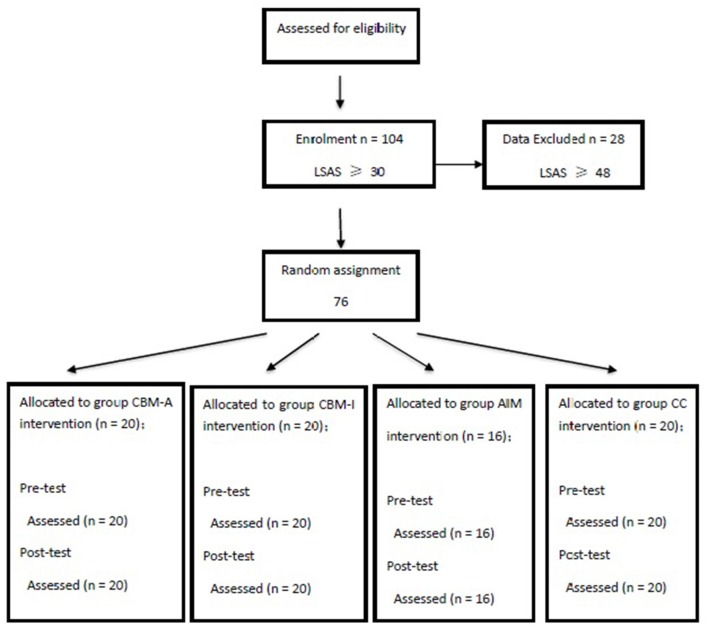
Flow chat of participants through each stage of the study.